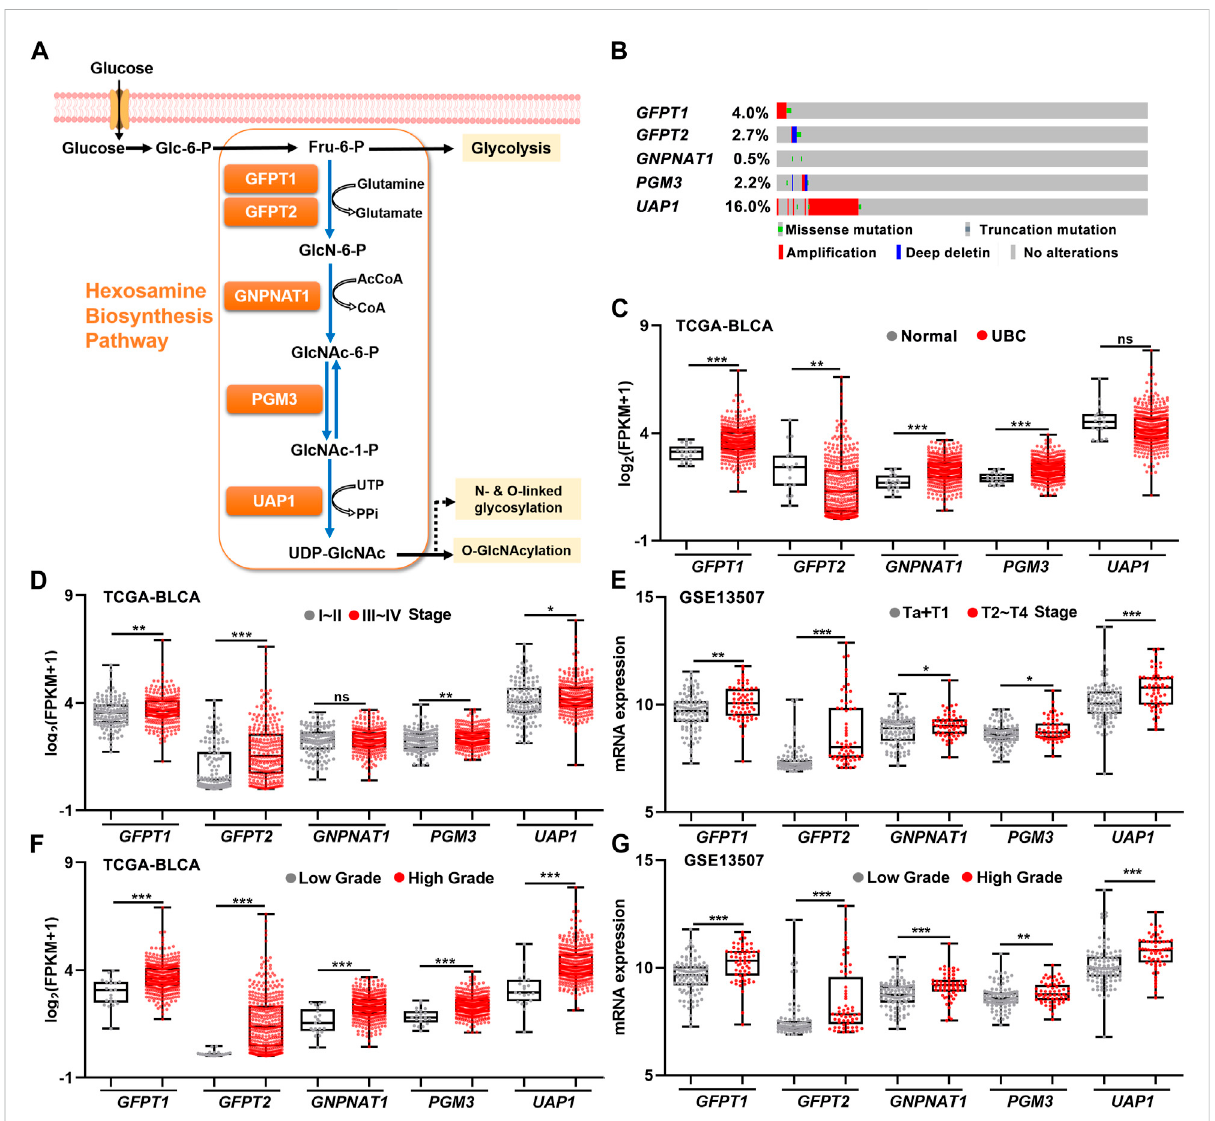
FIGURE 1 Therelationshipsbetweengeneexpressionlevelsof fi veHBPgenesandclinicopathologicalfactorsinUBCpatients. (A) Schematicillustrationof the HBP with fi ve key HBP enzymes, including GFPT1 , GFPT2 , GNPNAT1 , PGM3, and UAP1 . (B) The genetic alterations of fi ve HBP genes in human UBC patients derived from TCGA dataset. (C) The mRNA levels of fi ve HBP genes in normal bladder tissues ( n = 19) and UBC tissues ( n = 406) in TCGA-BLCA dataset. (D,E) The mRNA levels of fi ve HBP genes in low stage (stage I – II, n = 131; or Ta + T1, n = 104) and high stage (stage III – IV, n = 273; or T2 – T4, n = 61) of UBCs from TCGA-BLCA (D) and GSE13507 (E) , respectively. (F,G) The mRNA levels of fi ve HBP genes in low- and high- grade of UBCs from TCGA-BLCA (F) ; Low Grade ( n = 21) vs . High Grade ( n = 382), and GSE13507 (G) ; Low Grade ( n = 105) vs . High Grade ( n = 60), respectively. * p < 0.05, ** p < 0.01, *** p < 0.001, and ns, non-signi fi